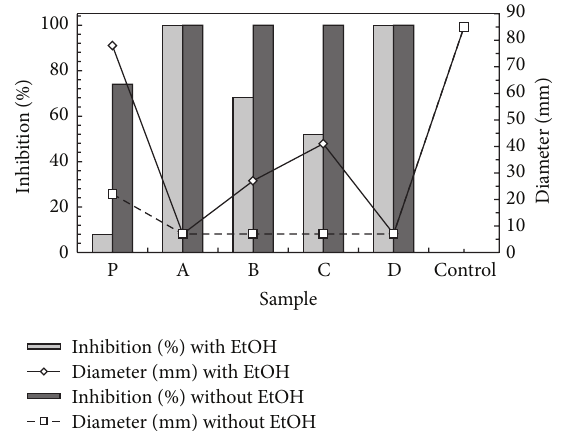
Figure 7: Inhibition percentage and growth diameter of the Diplodia seriata fungus mycelia for propolis (P), chitosan oligomers (A), chitosan oligomers/propolis (B), chitosan oligomers/propolis/silver NPs (C), chitosan oligomers/silver NPs (D), and control, in aqueous solutions (without EtOH) and in hydroalcoholic solutions (with EtOH).